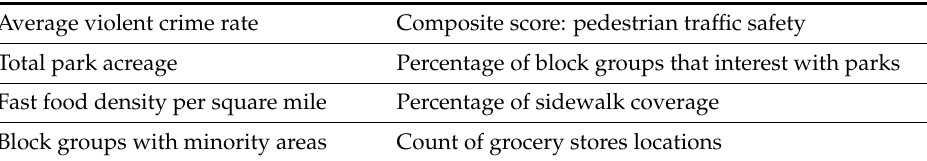
Table 6. Environmental factors that affect PrLE (Adapted from [1]).